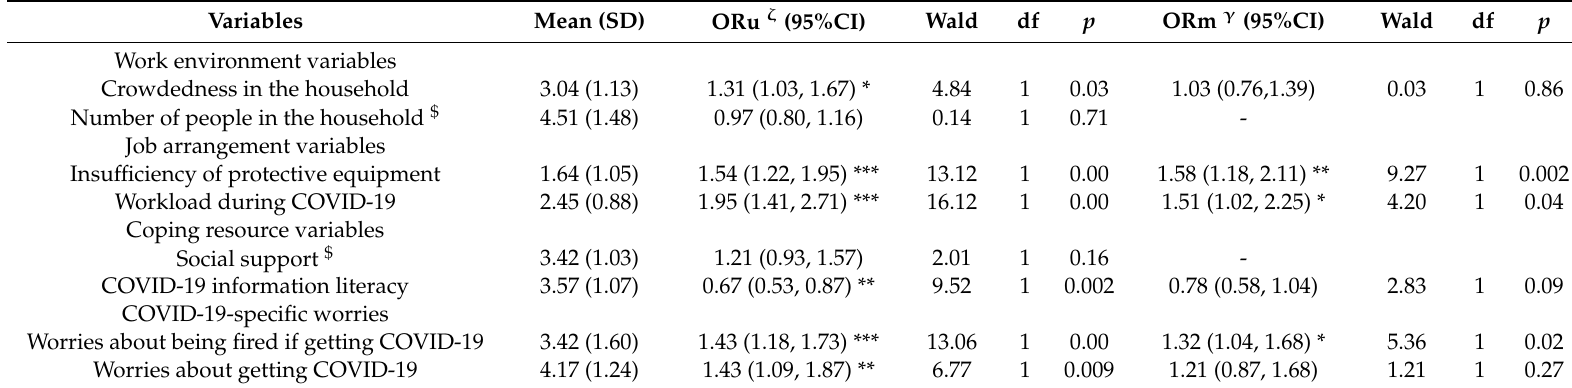
Table 3. Odds ratios and confidence intervals of independent variables associated with probable anxiety (GAD-7 ≥ 10) ( n = 295).